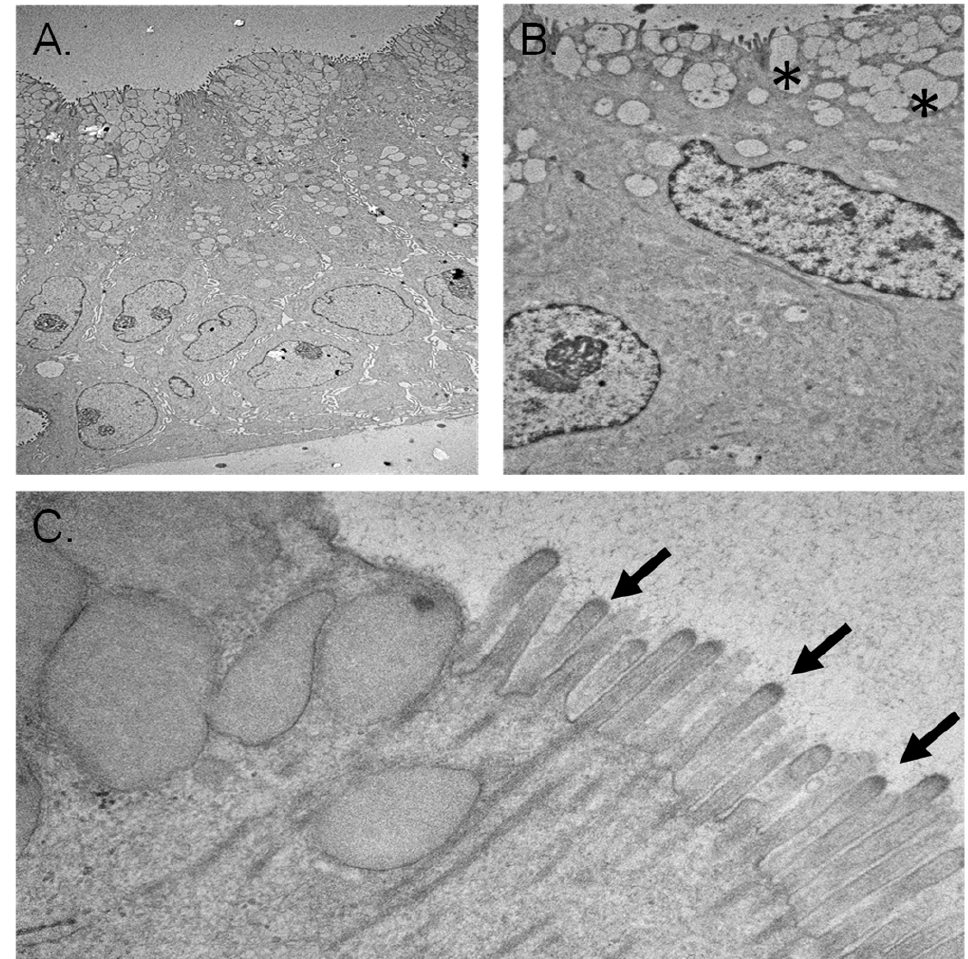
Figure 7. Electron microscopy of chol-orgs. ( A ) Luminal (top of panel) and basal surfaces (bottom of panel) are represented. The pattern of cell nuclei near the basal surface is consistent with a multilayer epithelial structure. ( B ) Higher magnification image demonstrates concentration of secretory vesicles (denoted by *) near the luminal border of the chol-org. ( C ) Cilia (arrows) are present along the luminal surface.